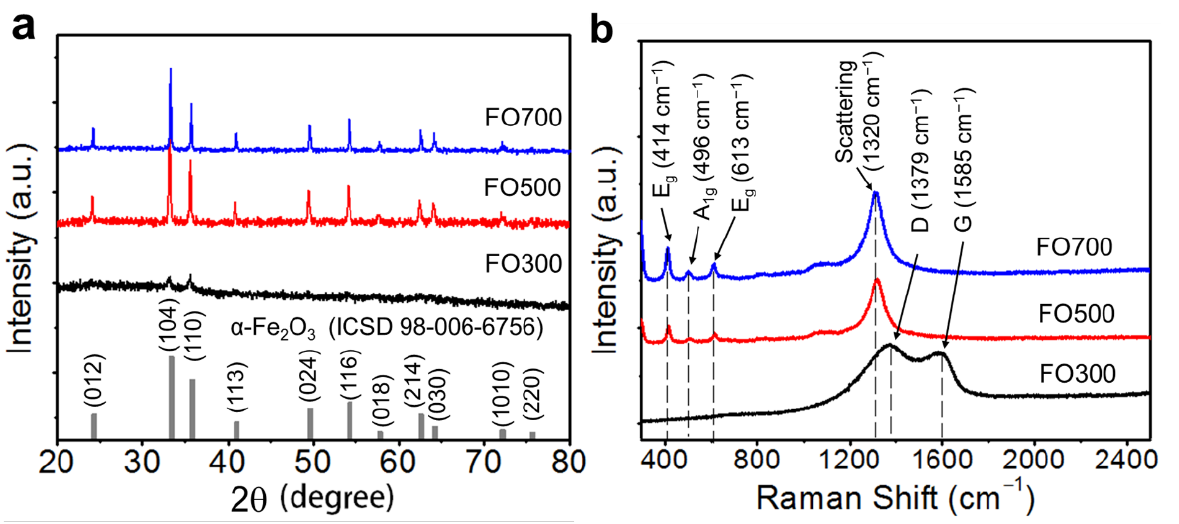
Figure 2. ( a ) XRD patterns and ( b ) Raman spectra of the α -Fe 2 O 3 nanofibers annealed at 300, 500, and 700 °C, denoted as FO300, FO500, and FO700,